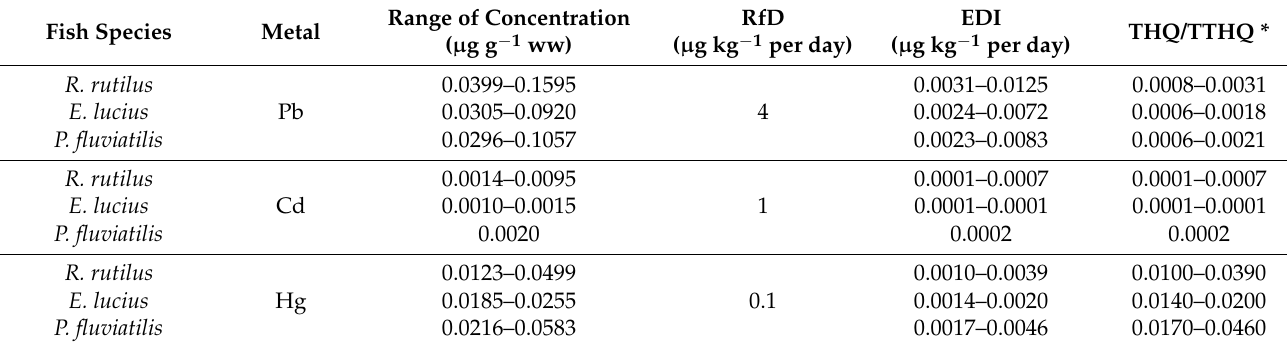
Table 5. The estimated daily intakes (EDI) of the metals by the consumption of the examined fish and hazard quotient (THQ and